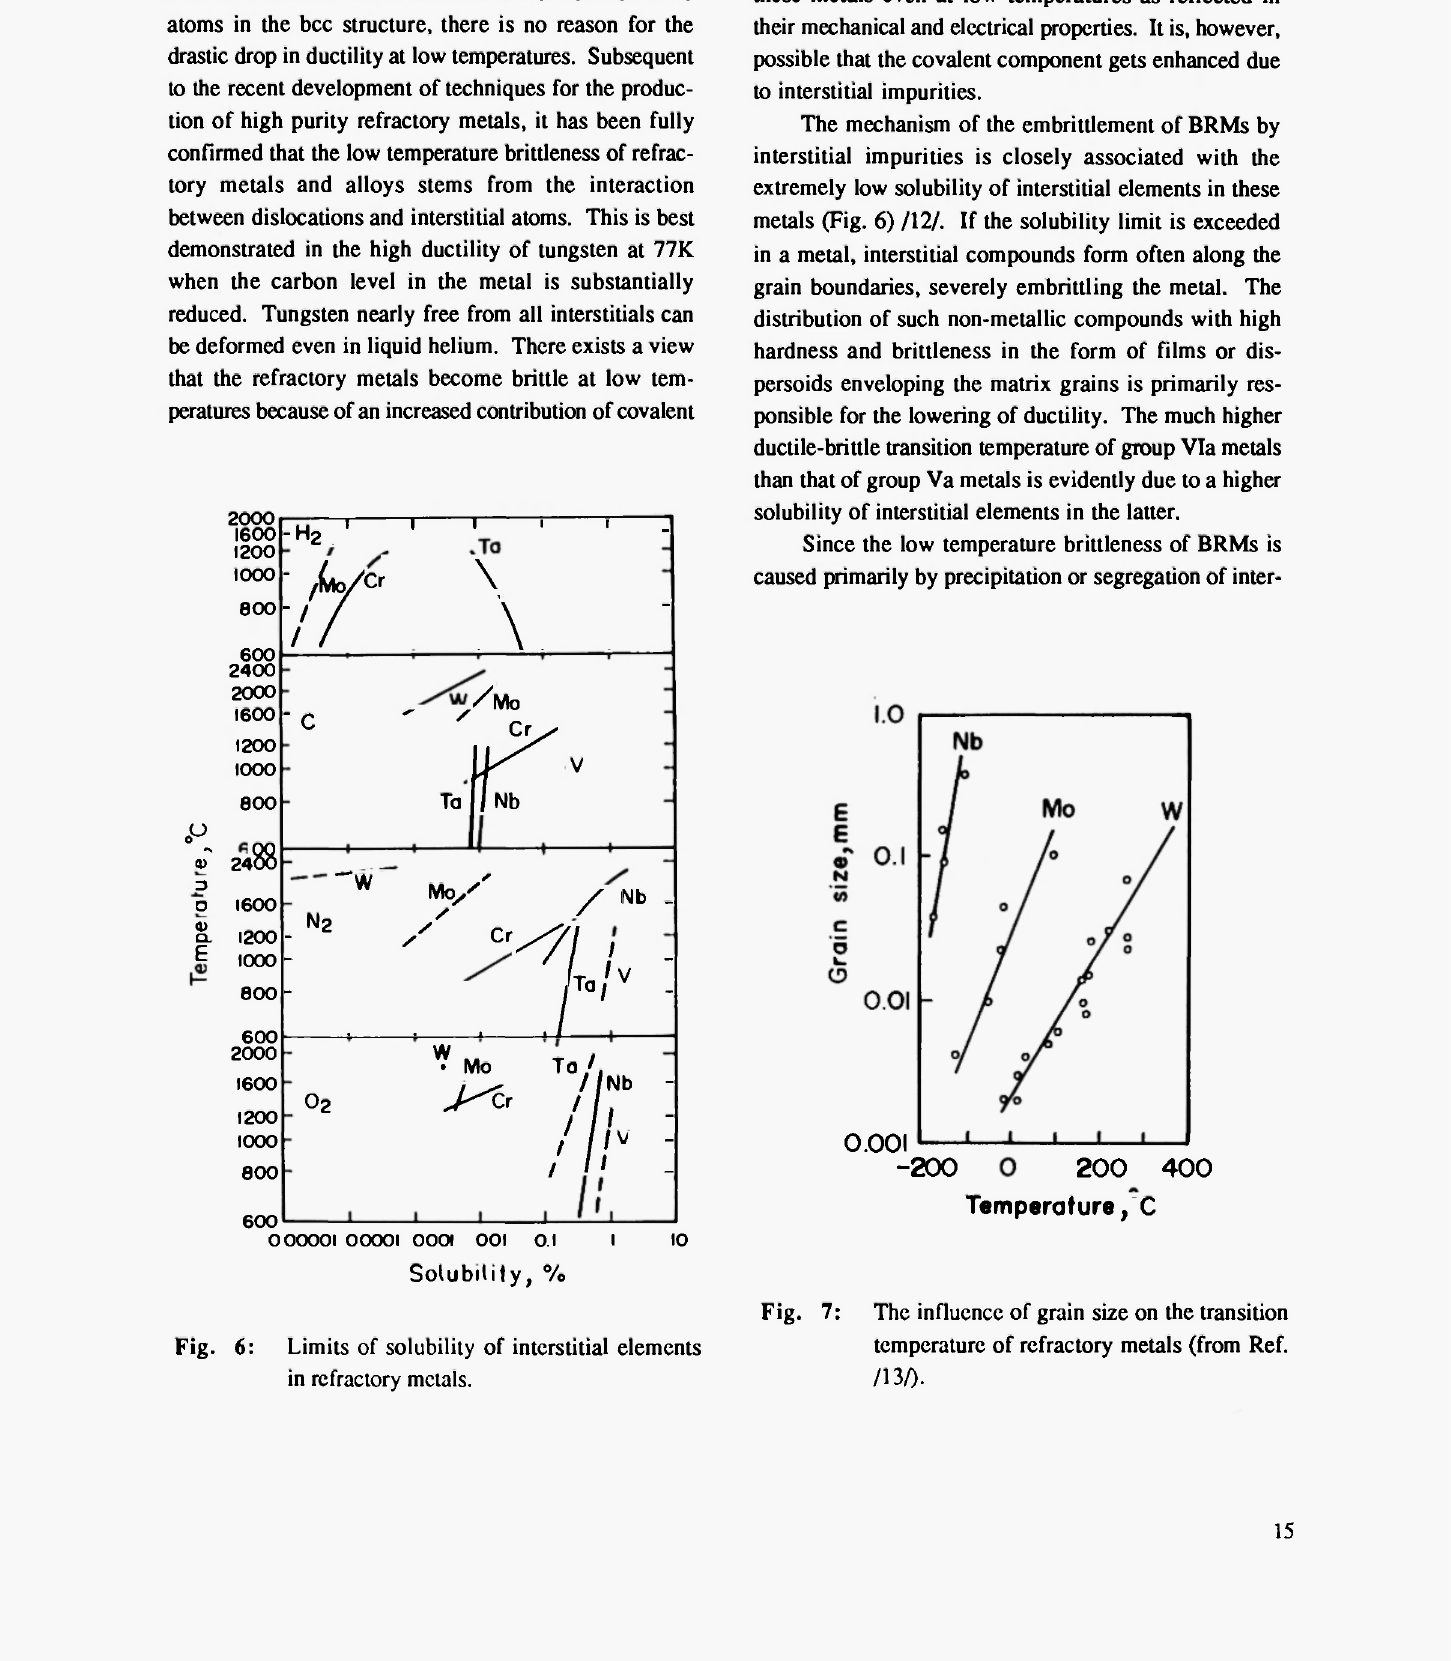
The influence of grain size on the transition temperature of refractory metals (from